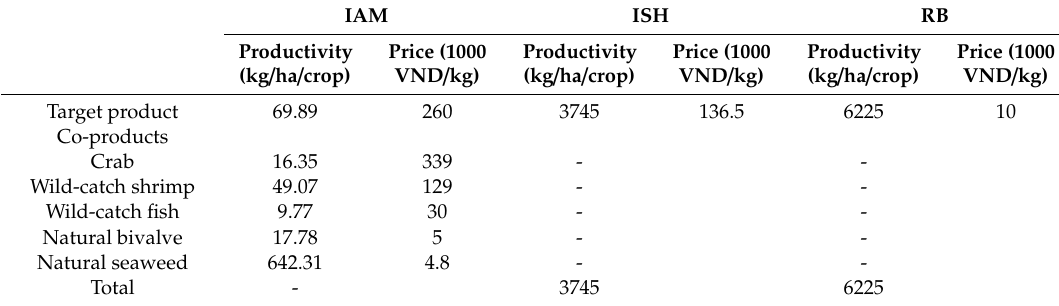
Table 5. Productivity and farm-gate